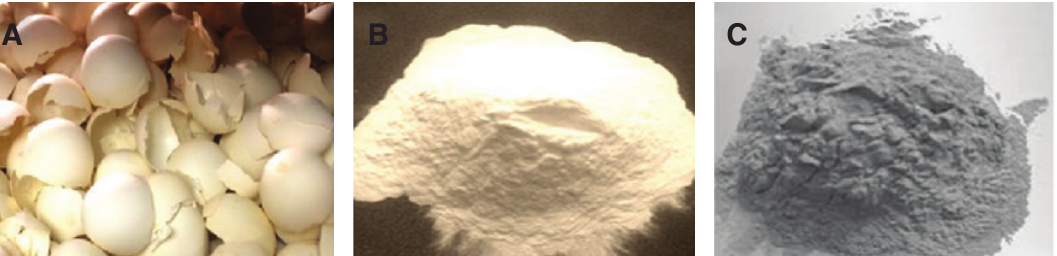
Figure 1: Photographs of (A) eggshells, (B) eggshell powder, and (C) carbonized eggshell powder.